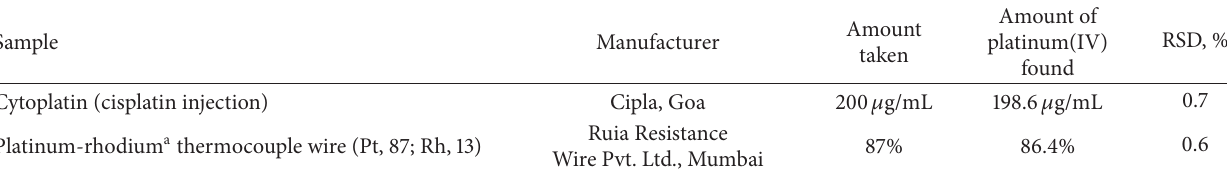
Table 8: Analysis of platinum(IV) from real